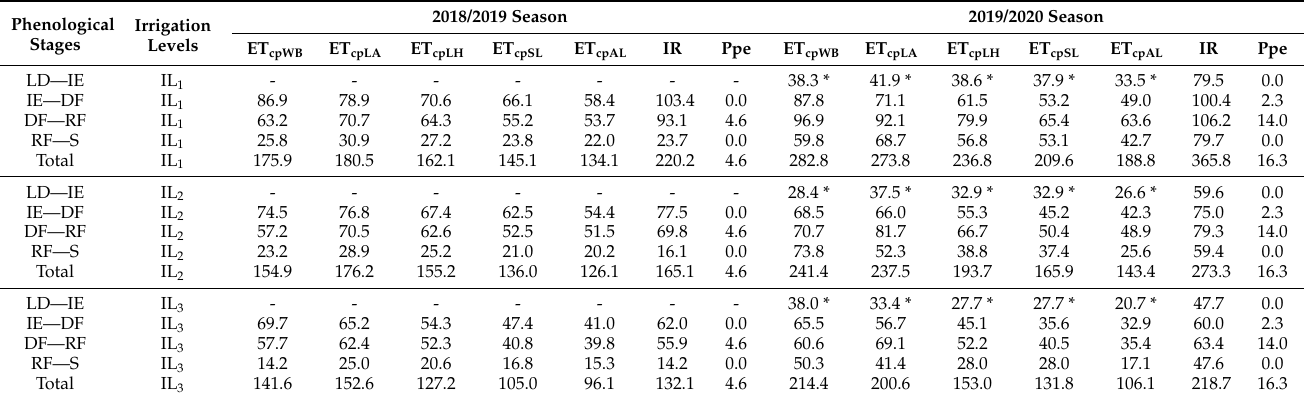
Table 4. Evapotranspiration estimated by the canopy resistance approaches, effective rainfall (Ppe, mm) and irrigation (IR, mm) applied in each irrigation level condition during the main potato phenological stages, and maximum water demand by the atmosphere for both